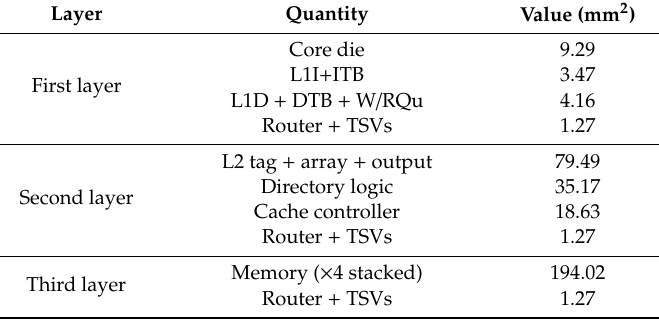
Table A2. Area evaluations on three stacked